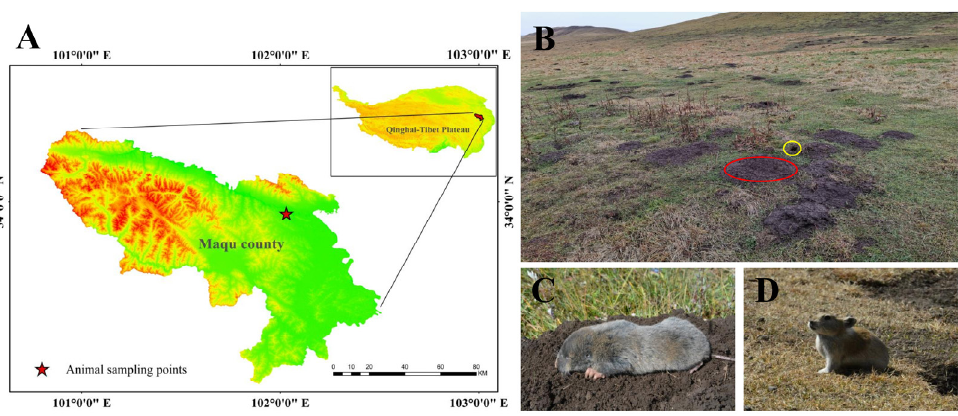
Figure 1. Experimental animals and their habitats in this study. ( A ) The sampling location of experimental animals; ( B ) the habitat of sympatric distribution of the plateau zokor and plateau pika (the red circle indicates a mound made by the plateau zokor and the yellow circle indicates a hole made by the plateau pika); ( C ) plateau zokor; ( D ) plateau pika.